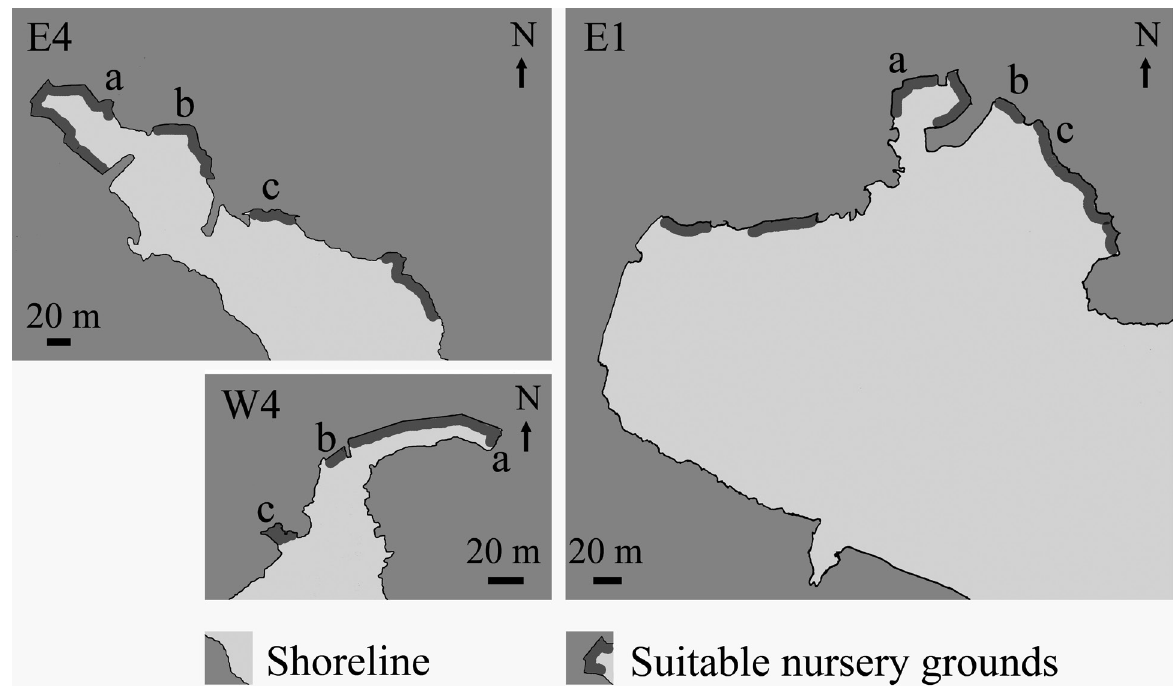
Fig . 2. – Shaded areas represent the location of suitable microhabitats for Diplodus settlers (nursery grounds) in the three studied Calanques; E4 = Morgiou; E1 = Sormiou; W4 = Callelongue; Labels (a, b, c) indicate the three monitored nursery replicates in each